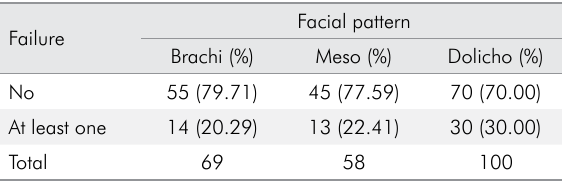
Table 5. MSI failure according to craniofacial pattern.